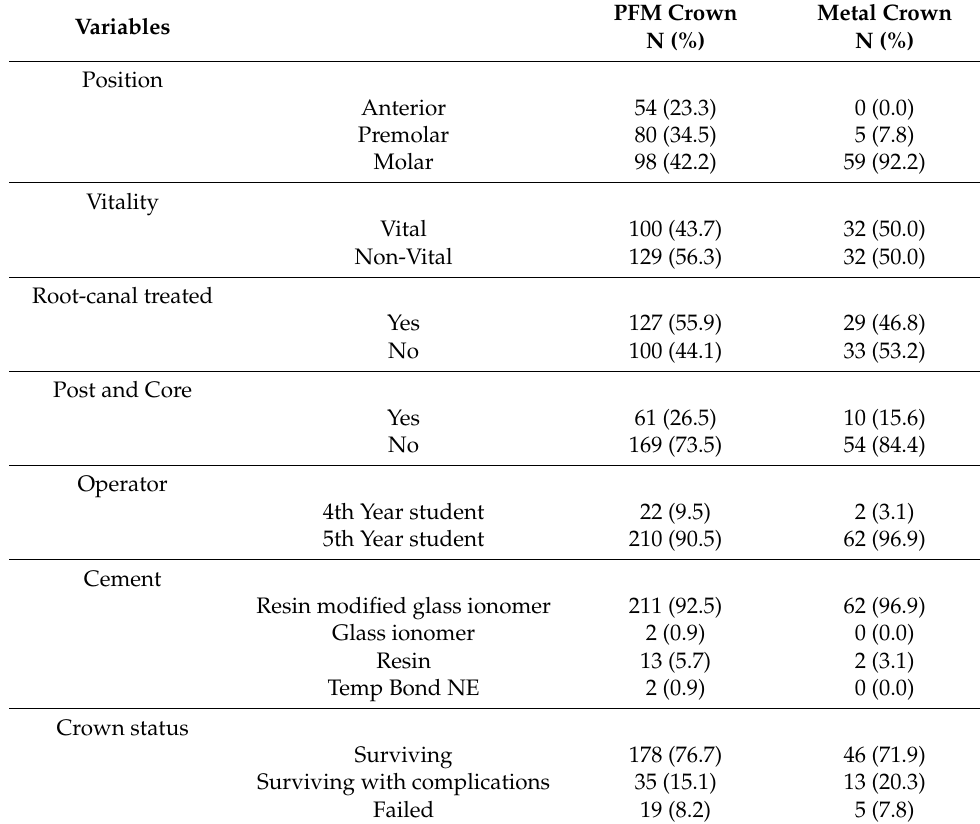
Table 2. Summary information of crowns (N = 296).